Question: What kind of plot is shown here?
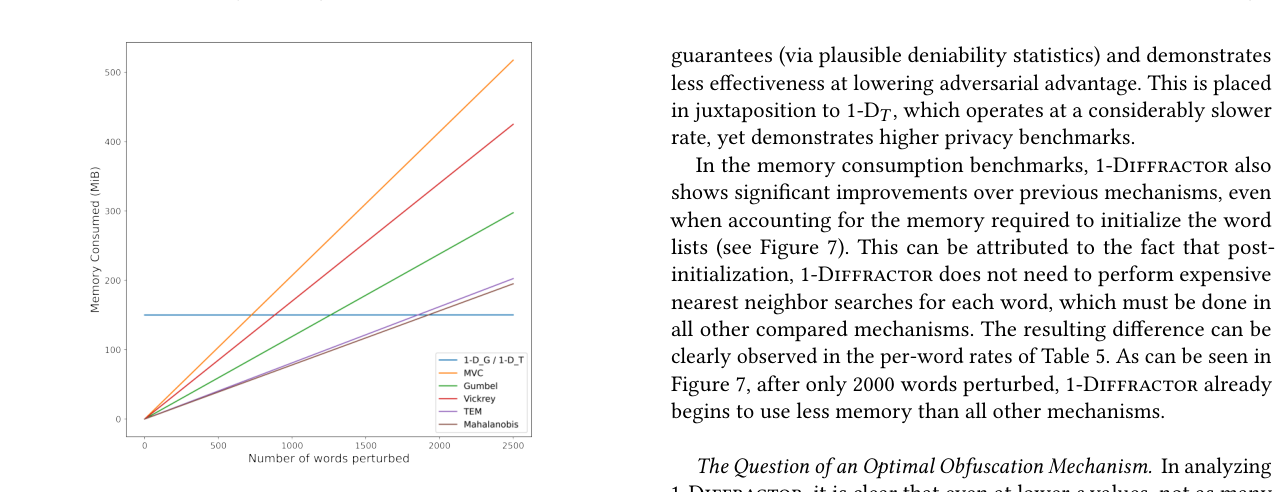
Answer: line